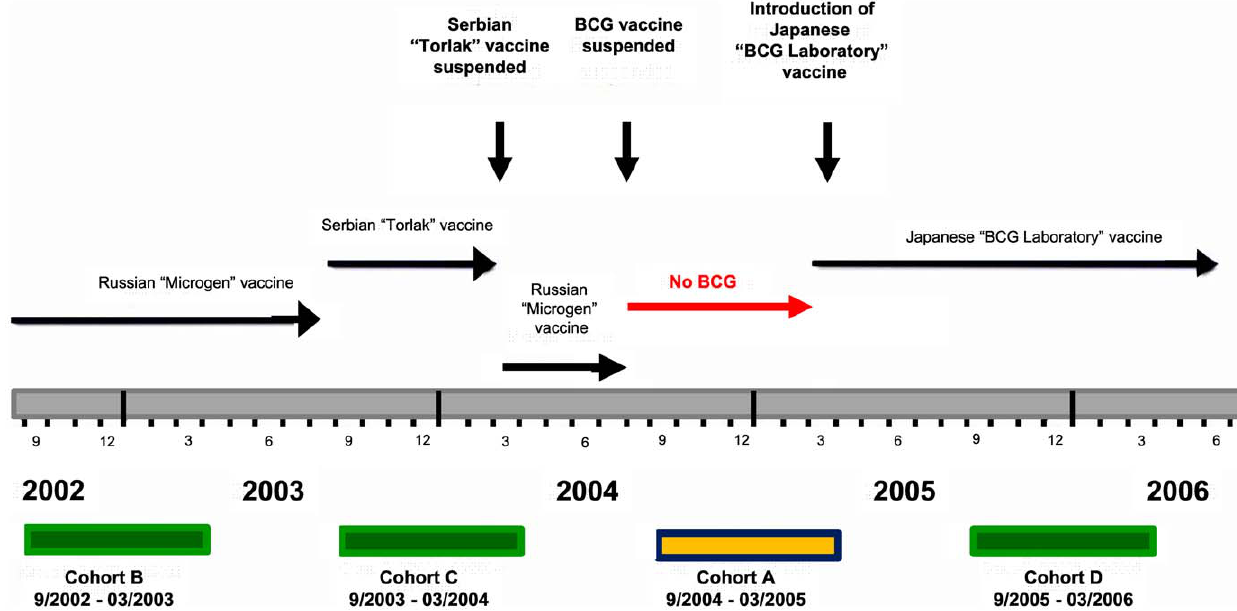
Figure 1. Cohorts of vaccinated and non-vaccinated children in Kazakhstan, 2002–2006.